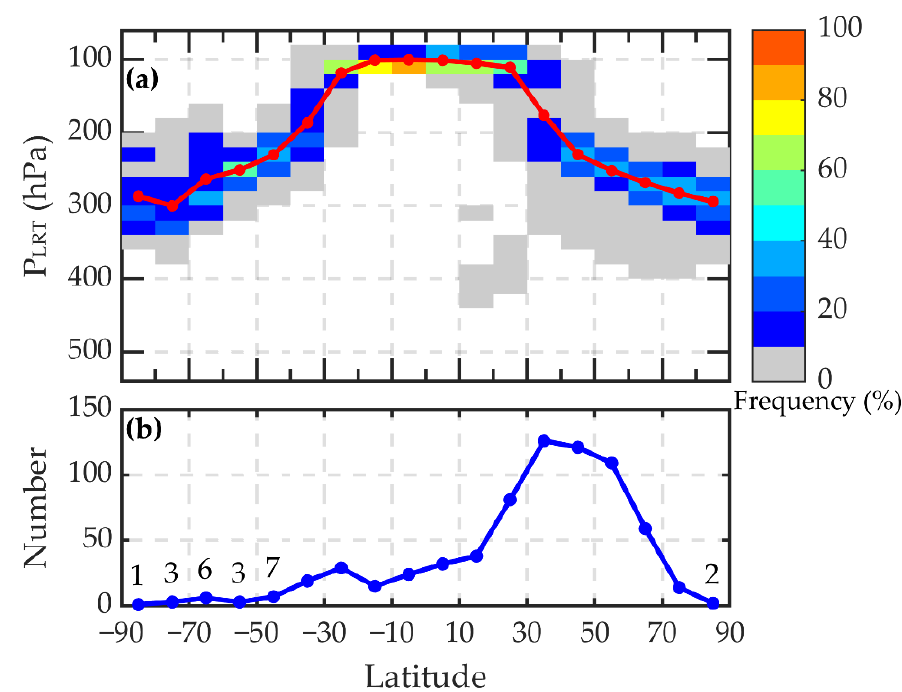
Figure 1. ( a ) The red line shows the latitudinal variation in the climatological lapse-rate tropopause pressure (P LRT) averaged over 1980–2017. The colors show occurrence frequency of different P LRT intervals in each latitudinal bin at selected radiosonde stations. The pressure altitude ranges from 500–100 hPa. ( b ) The number of the selected stations varying with latitude.